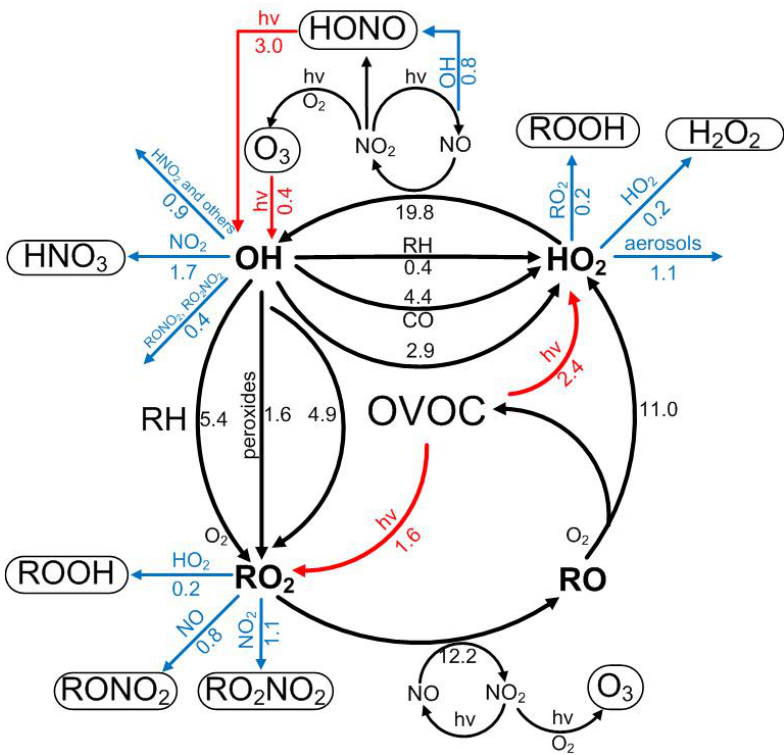
Fig. 2. Daytime (06:00–18:00) average budgets of RO x radicals. Primary RO x sources and sinks are in red and blue, respectively. The production and loss rates are in ppbvh − 1